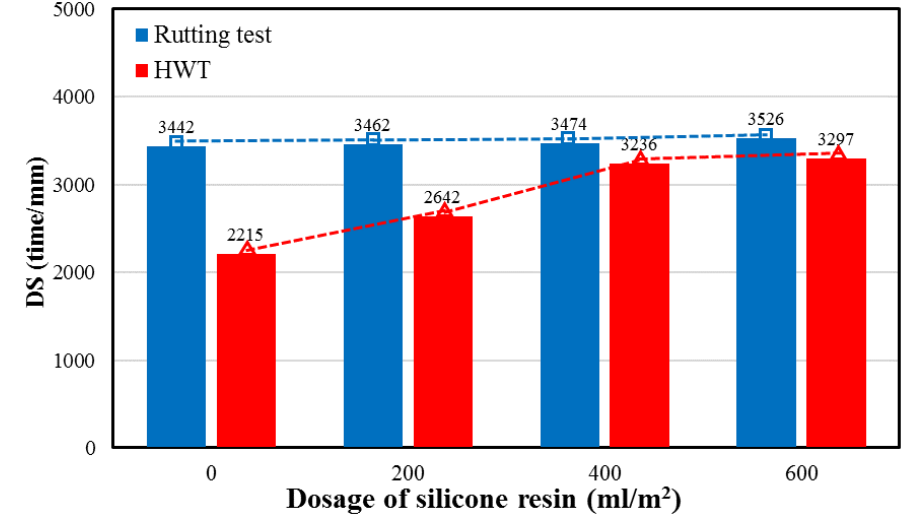
Figure 13. High-temperature stability of asphalt mixture at various silicone dosages.